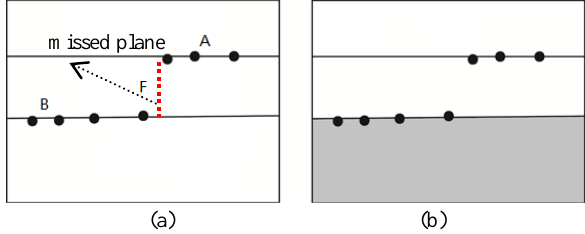
Figure 10. Profile of a reconstruced flat roof: (a) missed facade F and (b) labelled gray cell.